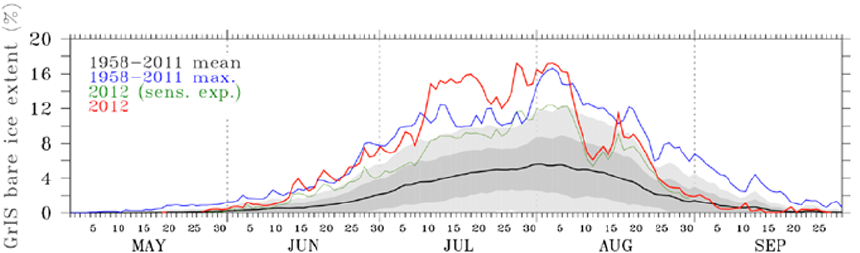
Fig. 9. Same as Fig. 6e but for the daily bare ice extent (where the snow density is higher than 900kgm − 3 ) in percentage of the GrIS area from MAR.